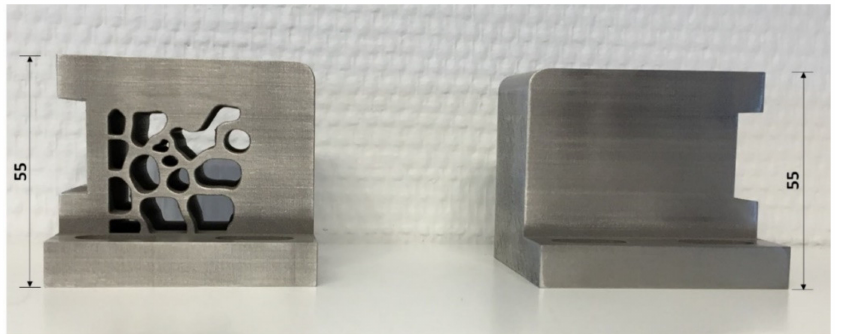
Figure 8. The U-bending tool: the right tool half was 3D-printed (L-PBF) as a solid piece. The left tool half was topology optimized at the volume fraction of 0.45 (Figure 9) and 3D-printed (L-PBF). Both tool halves were 3D-printed in maraging steel DIN 1.2709. Both tool halves managed 50,000 U-bends and were approved [129]. All displayed dimensions are in mm.